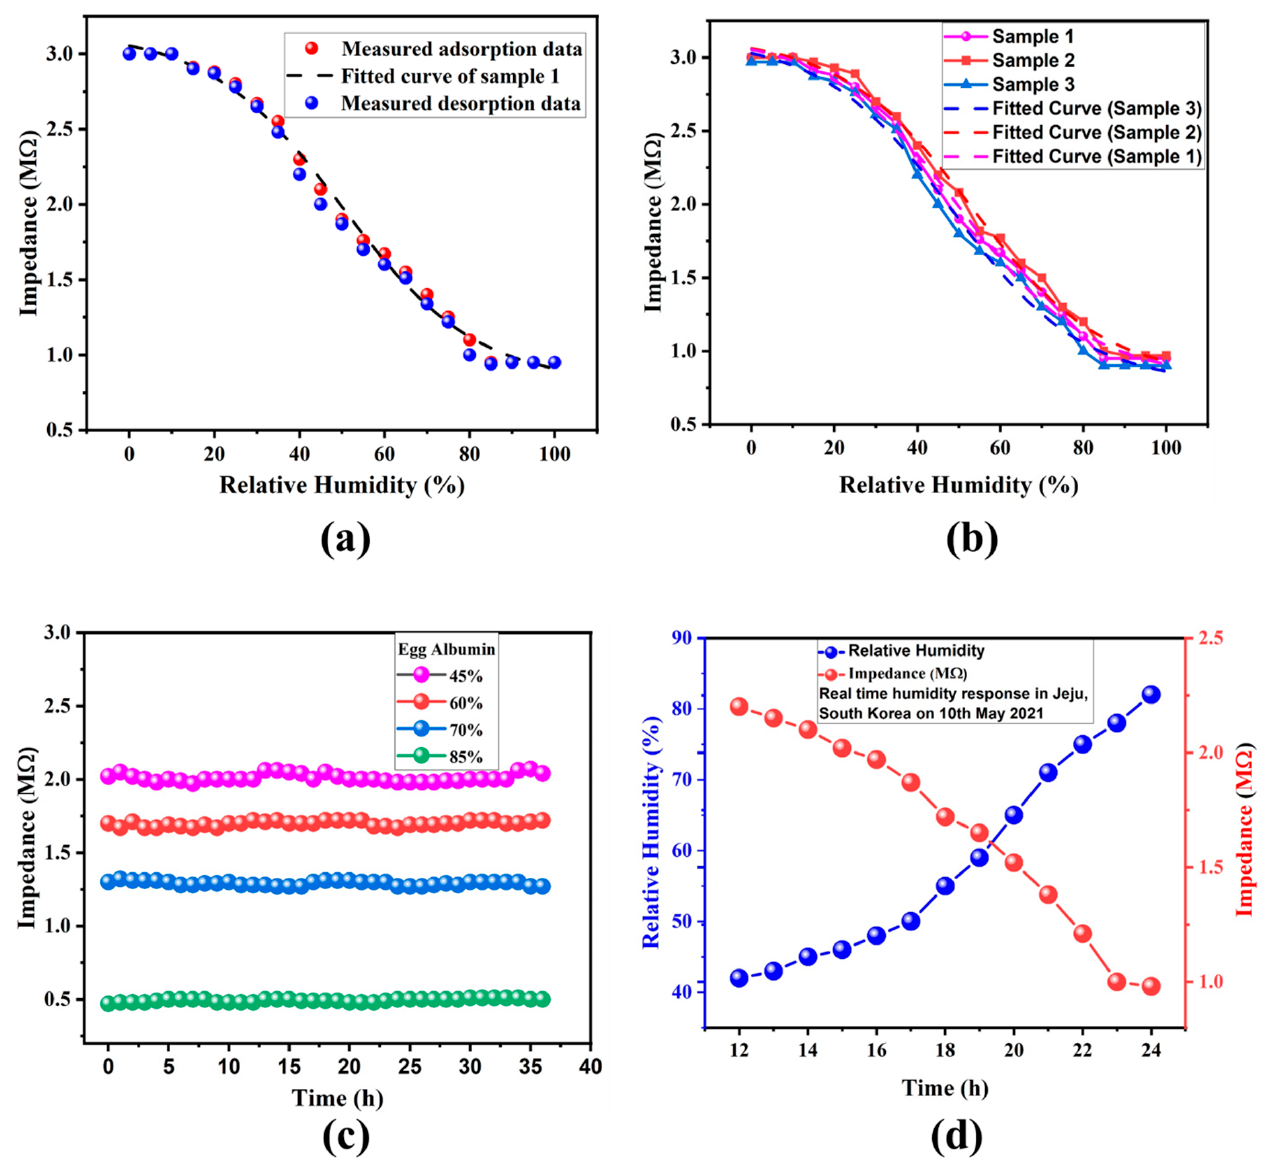
Figure 6. ( a ) Impedance response of egg white-based humidity sensor with change in RH%. ( b ) Impedance response of multiple egg white-based sensors, showing their reliability. ( c ) Stability of egg white-based humidity sensor at four different levels of RH%. ( d ) Real-time humidity response of fabricated sensor for 13 h in the open environment of Jeju on a rainy day.